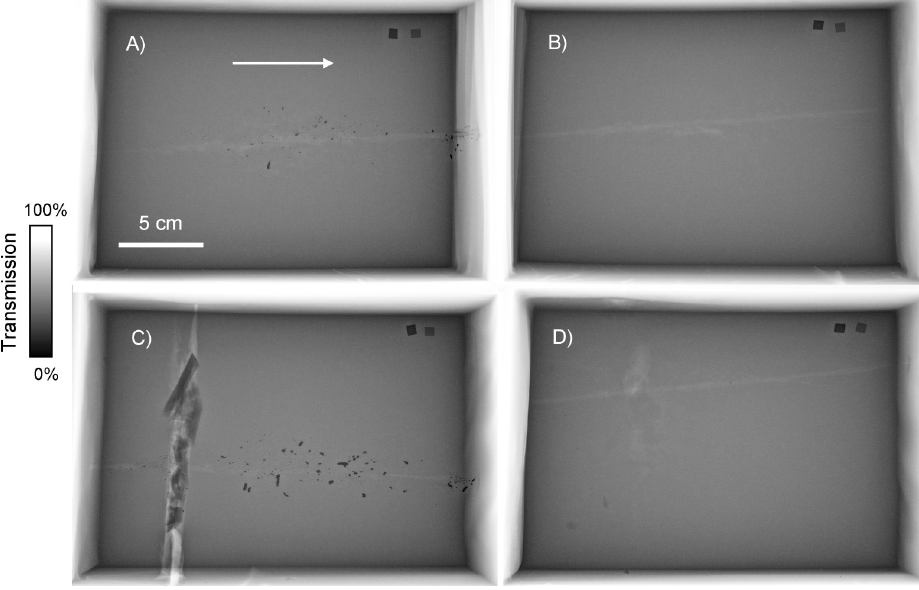
Fig 2. Medical radiographs of ballistic gelatin block samples. The bullet trajectory is indicated by the arrow, and all images are on the same spatial and contrast scales. (A) Lead-core bullet without bone. (B) Copper bullet without bone. (C) Lead-core bullet with bone. (D) Copper bullet with